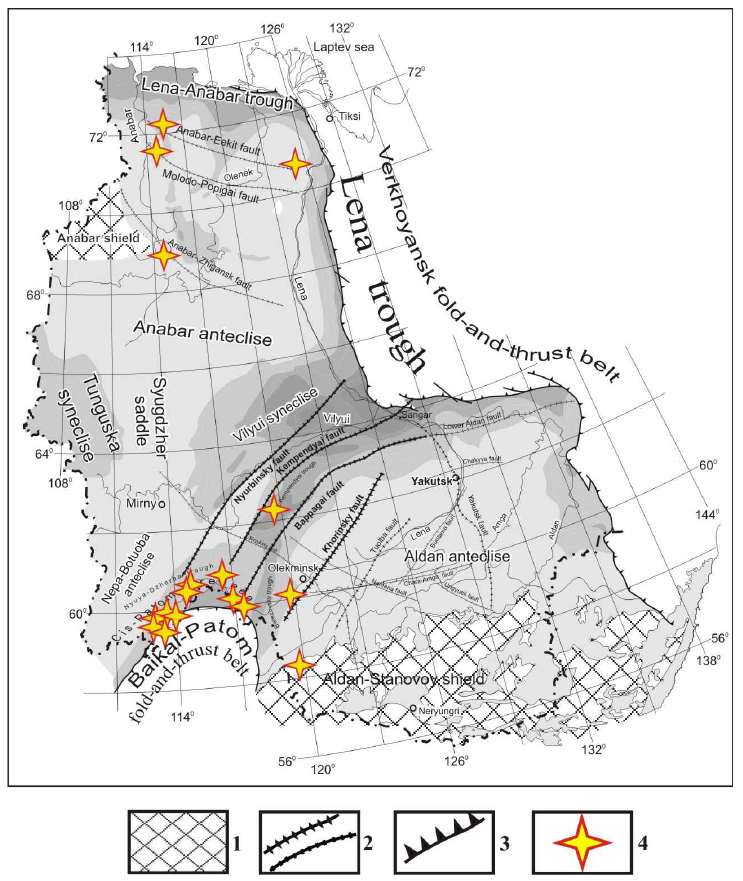
Figure 1. Mechanisms of the distribution of hydrothermal-metasomatic formations revealed as a result of the analysis of the location of placer gold of gold-sulfide-quartz mineralization. The basis is a relief map of the crystalline basement of the east of the Siberian Platform [18]: 1—areas of outcrops of crystalline basement rocks on the day surface; 2—faults; 3—front of the Phanerozoic orogenic belts; 4—supposed gold-bearing hydrothermal-metasomatic formations.